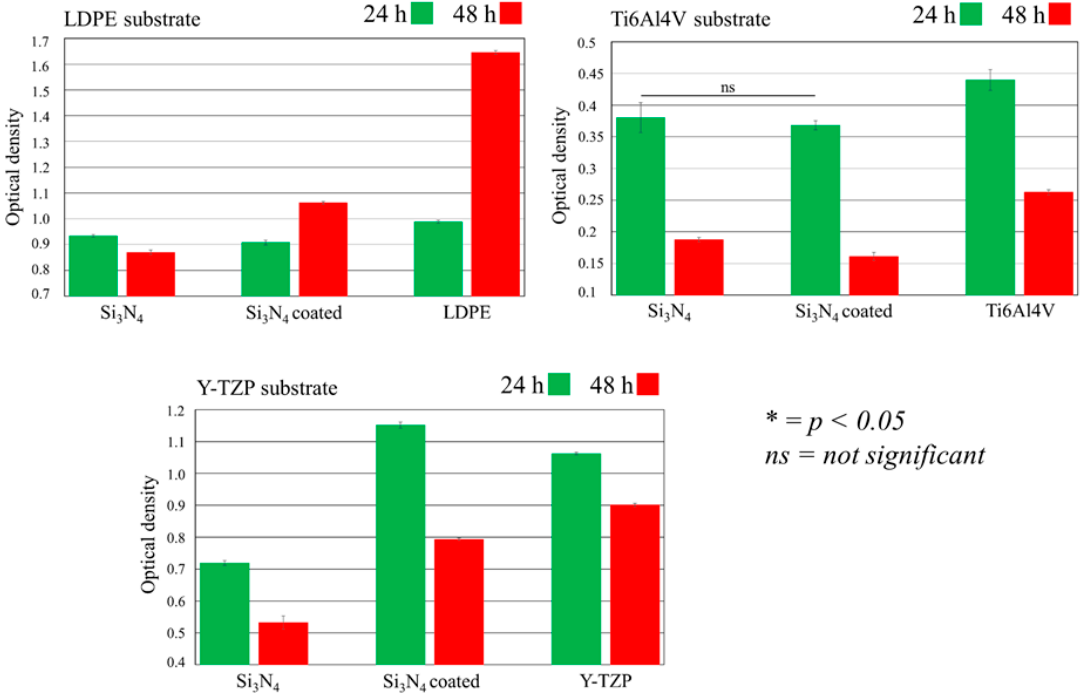
Figure 7. Biological assay of Staphylococcus epidermidis as an indicator of bacterial exposure time for all substrates.